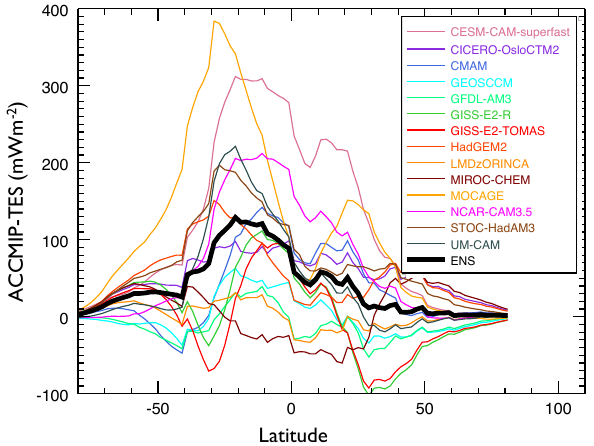
Fig. 5. Zonal δ OLR j m between ACCMIP and TES from 2005-2010, limited to 80 ◦ S–80 ◦ N, and is based on a TES diagnosed chem- Fig. 5: Zonal δ OLR j m between ACCMIP and TES from 2005-2010, limited to 80 ◦ S-80 ◦ N, and is ical tropopause ( q = 150ppb). The “ENS” refers to the ACCMIP based on a TES diagnosed chemical tropopause ( q =150 ppb). The “ENS” refers to the ACCMIP ensemble average, δ OLR j . Positive values indicate model ozone is ensemble average, δ OLR j . Positive values indicate model ozone is biased low relative to TES ozone biased low relative to TES ozone and consequently the model OLR and consequently the model OLR is biased high relative to TES OLR. is biased high relative to TES OLR.